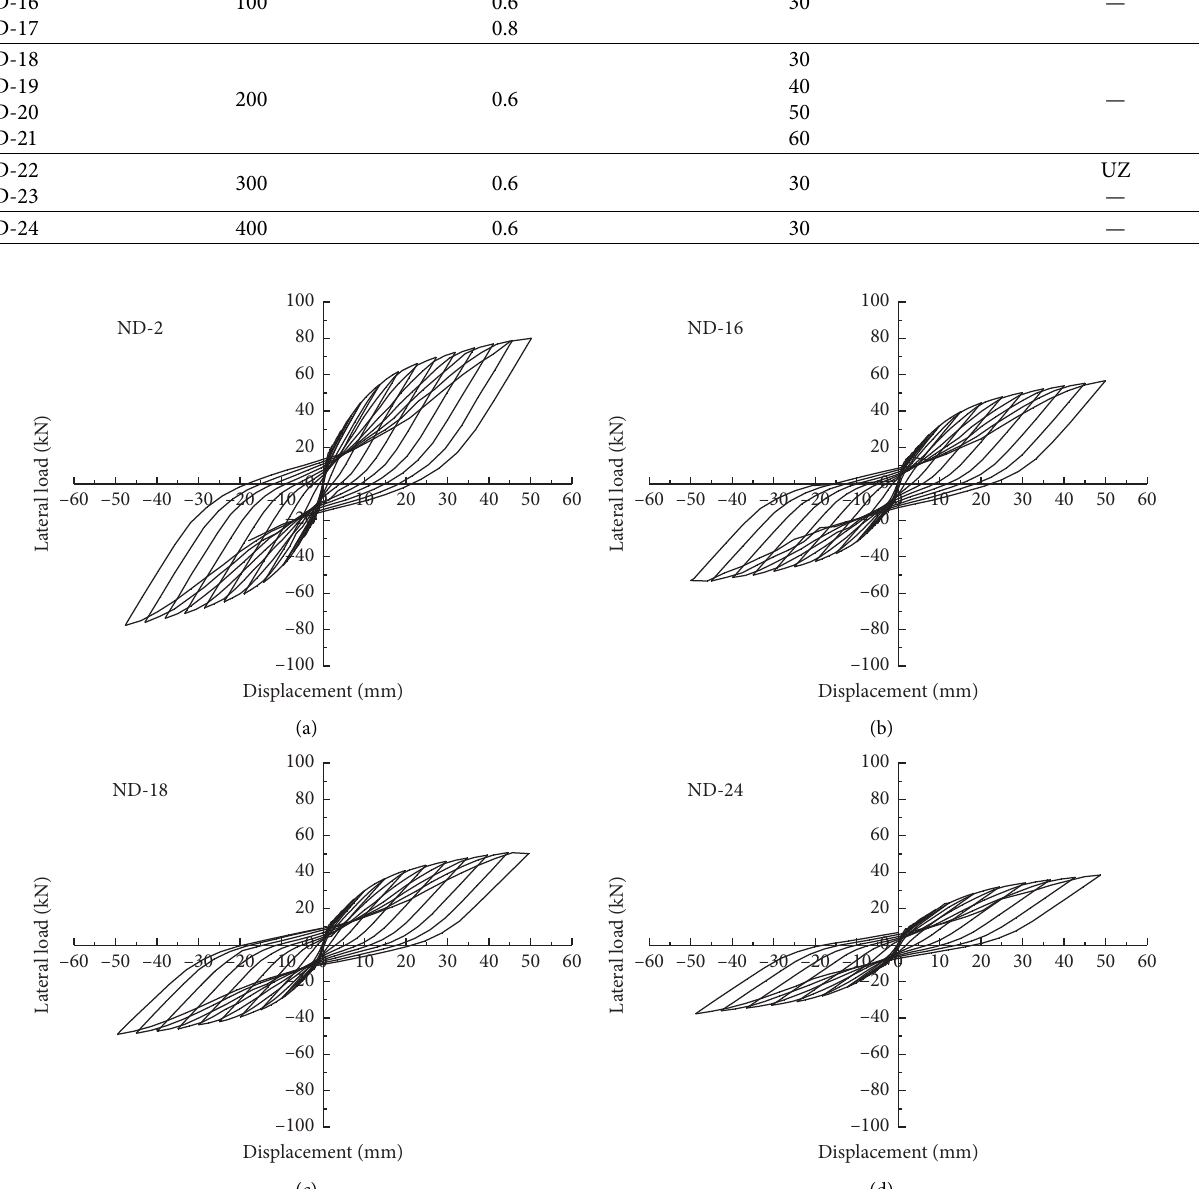
Figure 12: Hysteretic curves of different slit width. (a) 10mm. (b) 100mm. (c) 200mm. (d)